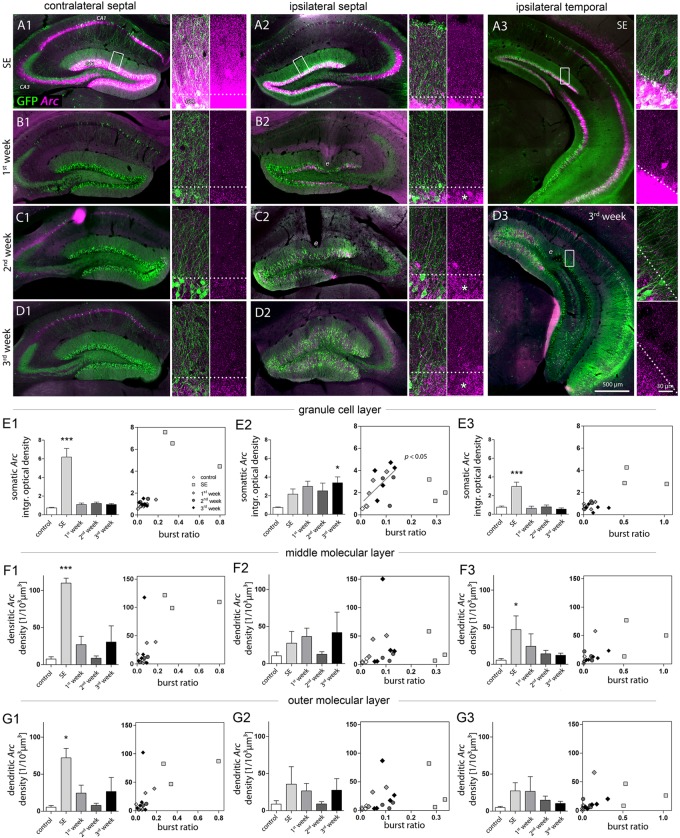
Characterization of DGC activity and synaptic input based on Arc expression. (A–D) Representative images showing Arc mRNA expression detected by FISH (magenta) during epileptogenesis (A, SE; B, first week; C, second week; D, third week). Transgenic Thy1-eGFP mice were used in which a subset of DGCs and also some pyramidal cells are intrinsically labeled with GFP (green). Each panel shows an overview of the hippocampus (left) and high-resolution confocal images of the dentate gyrus (right; displayed as a 3D maximum projection). Dashed lines denote the border between the granule cell layer (GCL) and the molecular layer (ML). Following SE, Arc mRNA stays upregulated in the ipsilateral GCL (asterisks). e indicates tissue distorted by electrodes. (E–G) Quantitative analysis of Arc mRNA density (left panel) in different layers (E, granule cell layer; F, middle and G, outer molecular layer) at different hippocampal locations (1, contralateral septal; 2, ipsilateral septal; and 3, ipsilateral temporal). Number of mice: ncntrl = 3–5, nSE = 3, n1w = 3, n2w = 3, n3w = 5. One-way ANOVA, Newman–Keuls’s post-test. ∗P < 0.05, ∗∗∗P < 0.001. Right panels show the corresponding linear-regression analysis (Pearson’s correlation) between Arc mRNA and the burst ratio. Correlations were performed excluding SE values (gray regression lines and P values), considering SE as a special case due to acute effects of KA on the network activity.